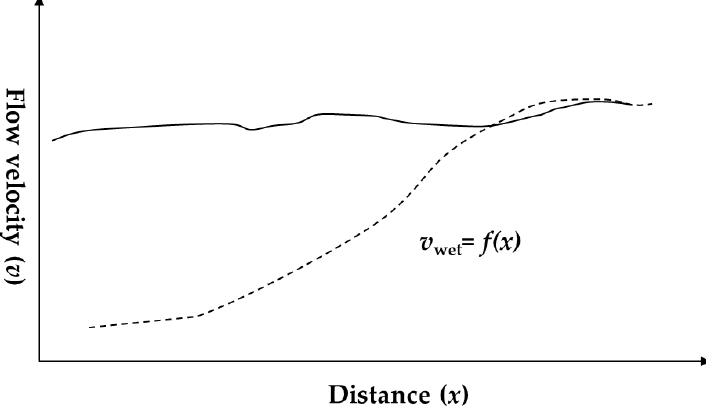
Figure 4. Relationship between the flow velocity ( v ) and the distance along the river ( x ) measured from the lake’s inlet (see Figure 3 for the inlet’s location); the same function was used in the wet and dry seasons.